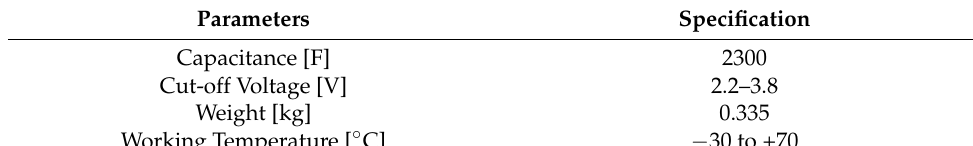
Table 1. Specifications of the 2300 F LiC cell.